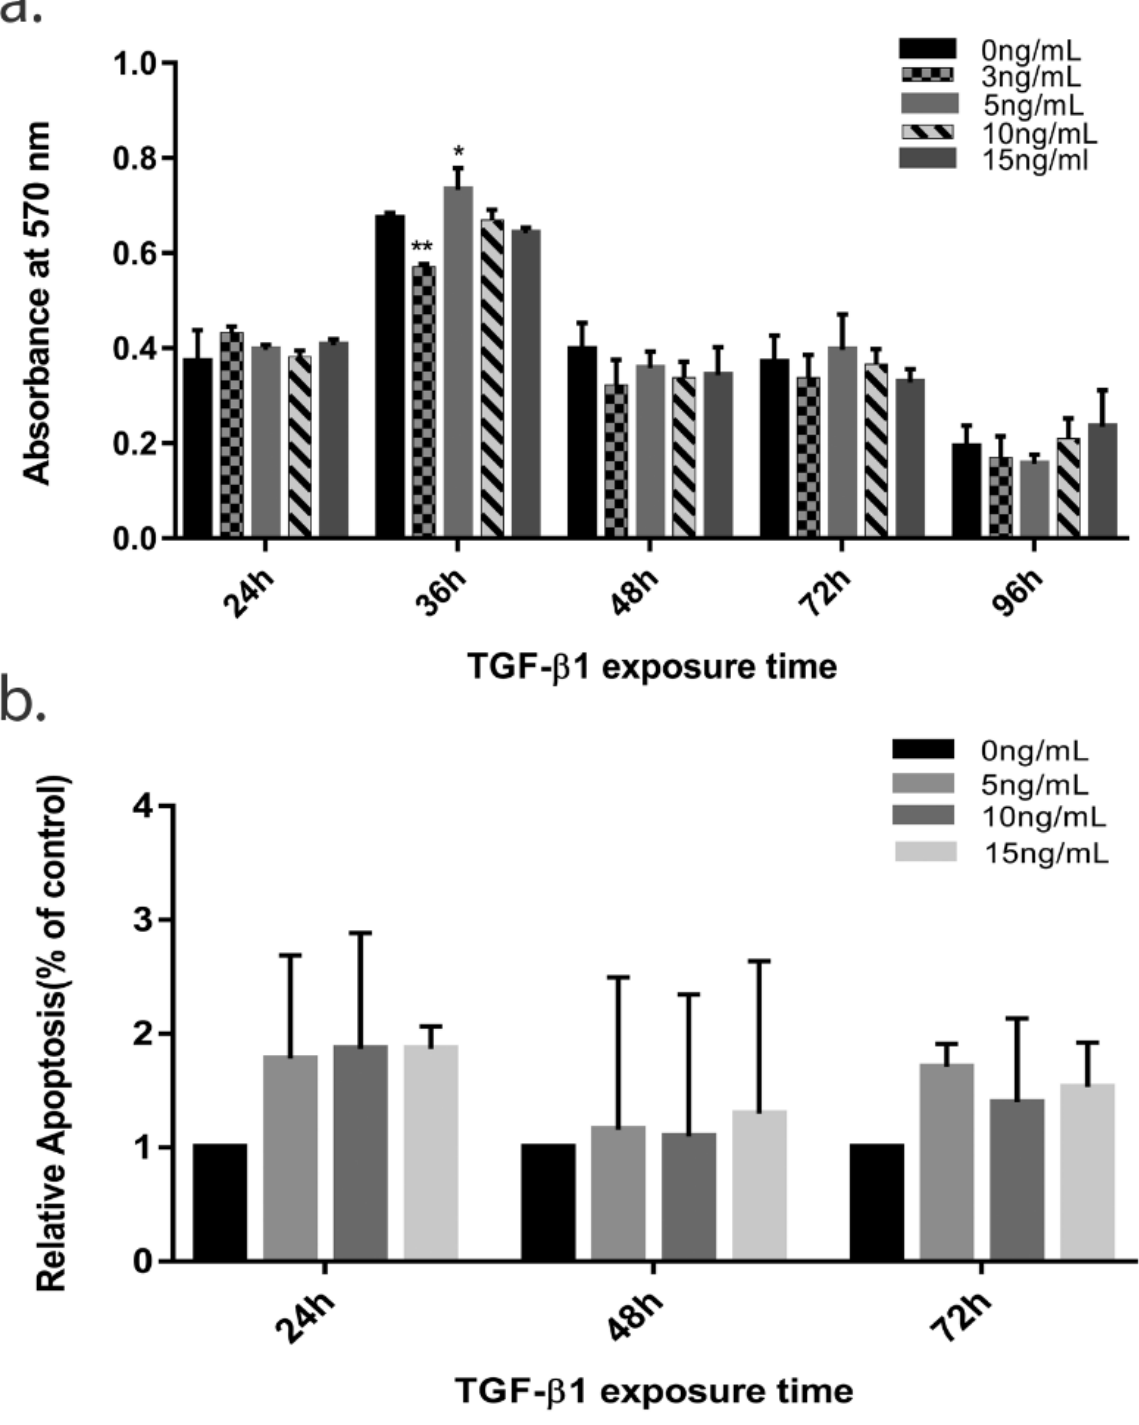
Figure 1. The effect of TGF- β 1 on TM cell viability and apoptosis. ( a ) TM cell viability for 96 h with or without TGF- β 1 treatment (3 ng/mL, 5 ng/mL, 10 ng/mL, 15 ng/mL). ( b ) Total apoptotic cells (early and late) plotted as Relative apoptosis (% control) against time at various TGF- β 1 treatment. The error bars represent standard deviation (* p < 0.05, ** p < 0.01 by one way